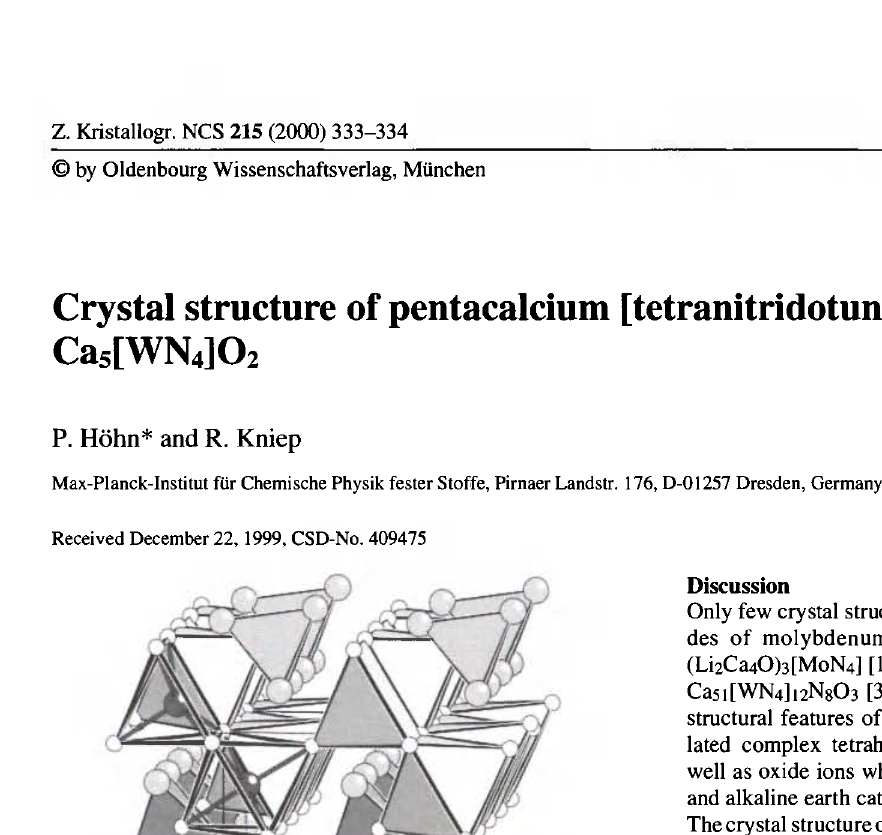
Table 1. Data collection and handling.